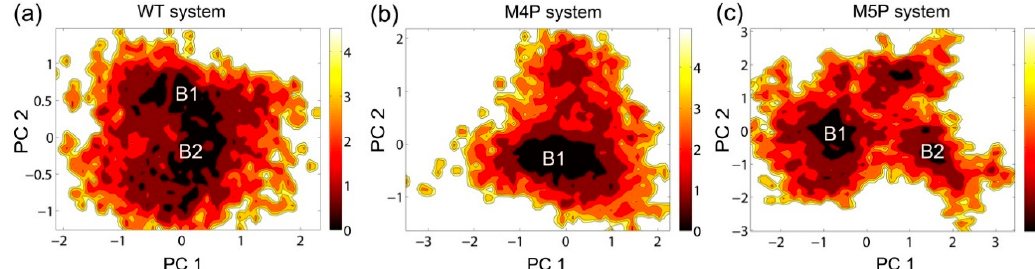
Figure 6. Free energy contour map depicted along the first and second principal components (PC1 & PC2) for WT ( a ), M4P ( b ) and M5P ( c ) systems. Deeper color area in the maps indicates lower energy. The distinctive local basins are denoted as B1 and B2, respectively.